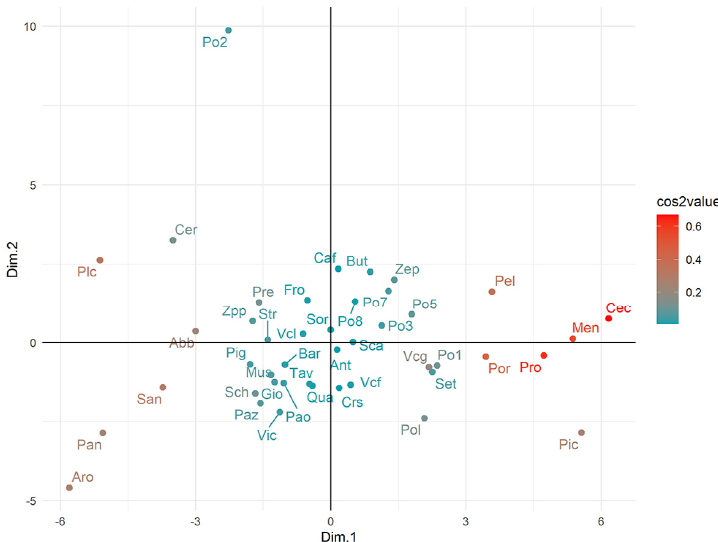
Figure 6. Factor Analysis of Mixed Data to represent the relationship among apricot landraces. Landraces are colored according to the squared coordinates (cos 2) following the color scale bar in the right-hand side of the scatterplot. The cos2 value, which ranges between 0 and 1, is indicative of the quality of representation on the factor map. Landraces abbreviations are reported in Table S1.